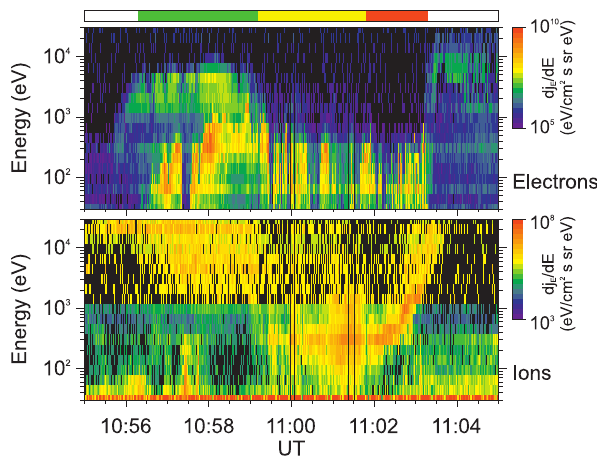
Fig. 2. The electron and ion spectra measured between 10:55 UT and 11:05 UT on 24 November 1998 onboard the DMSP-F11 space- craft. The satellite passed through three major particle regimes as it traversed the northern hemisphere auroral zone and polar cap. The colour bar at the top denotes the three major particle regimes en- countered by the